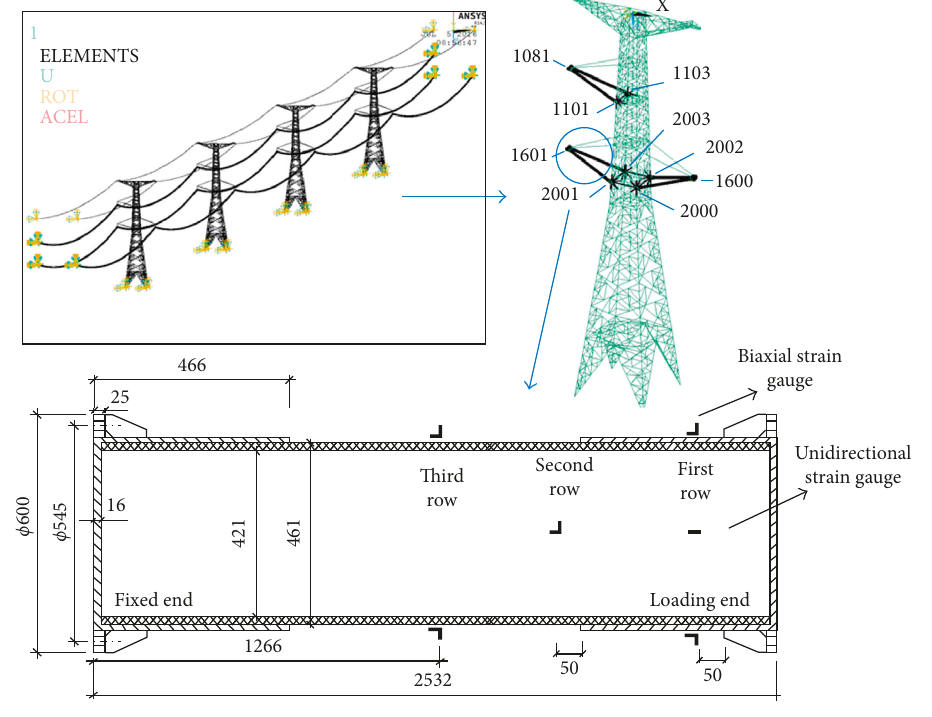
Figure 1: The specimen size and arrangement of measuring Table 1: Loading scheme.